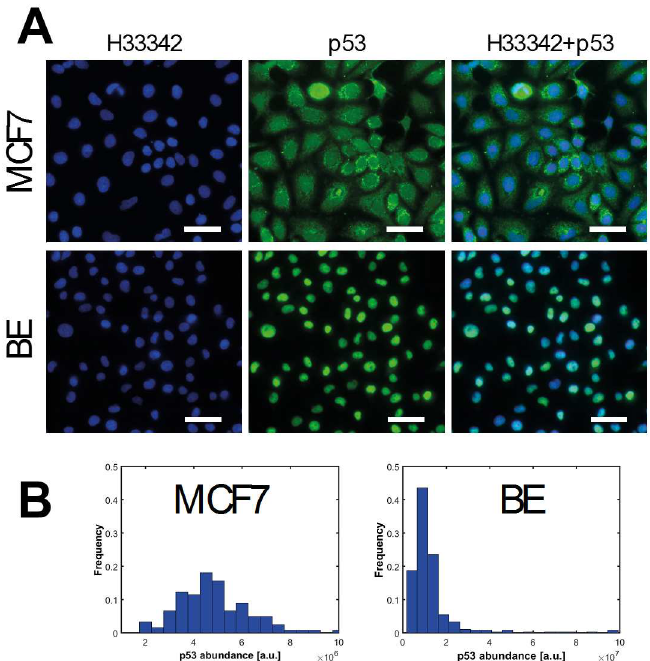
Fig 2. Results of single cell p53 immunofluorescencemeasurements. (A) Representative raw immunofluorescenceimages of fixed MCF7 (top row) and BE (bottom row) cells. Cells were stained directly using mouse monoclonal α -p53(DO-1) conjugated to Alexa Fluor 488 to visualisep53 protein (shown in green) and counterstained with Hoechst 33342to stain the nucleus(shown in blue). Overlaid images show that the p53 antibody stainingpattern is both cytoplasmic and nuclear in MCF7 cells, whereasin BE cells only the nucleusis stained. Scale bars 50 μ m. (B) Immunofluorescence images are processedand the p53 fluorescence intensity per cell is determined.Distributions of p53 fluorescence total intensity per cell for MCF7 (n = 122) and BE (n = 400) cells. Note the scale of arbitrary fluorescence units.